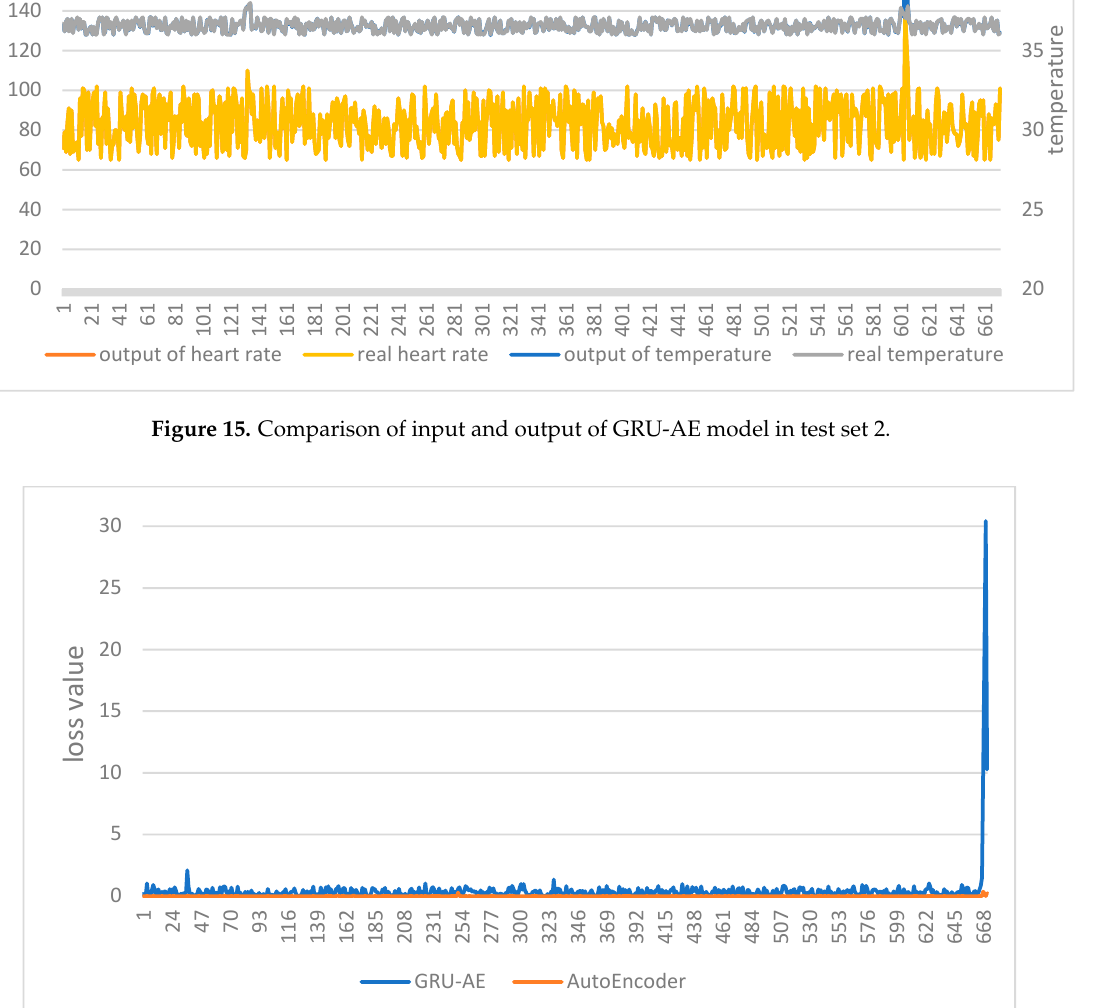
Figure 16. Comparison of the loss value changes of the two models in test set 1.